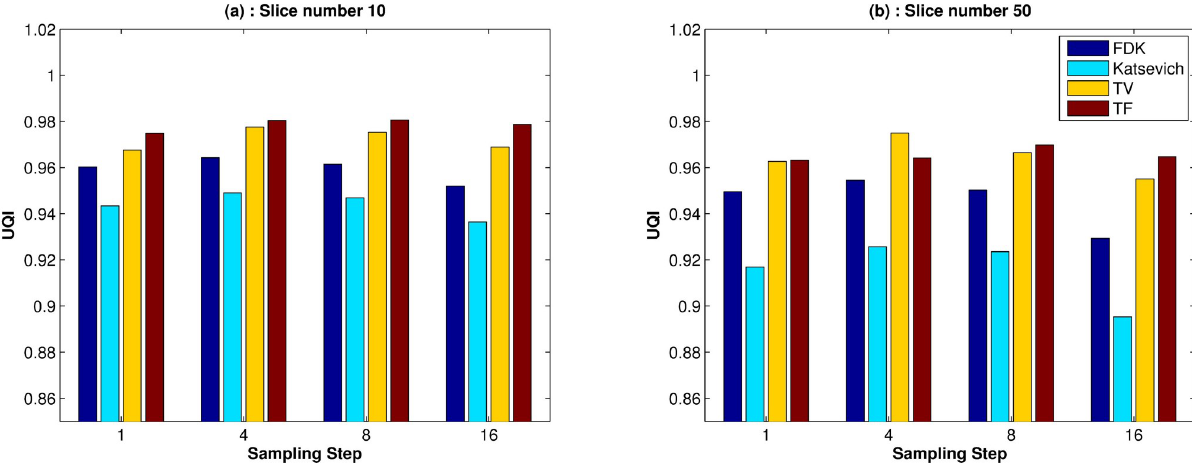
Fig 8. Image similarity measure: UQI results for various sampling step size. x - axis is the sampling step size, 1, 4, 8, and 16. y - axis is set as the UQI index. (a): UQI bar plot for the 10-th slice. (b): UQI bar plot for the 50th slice.